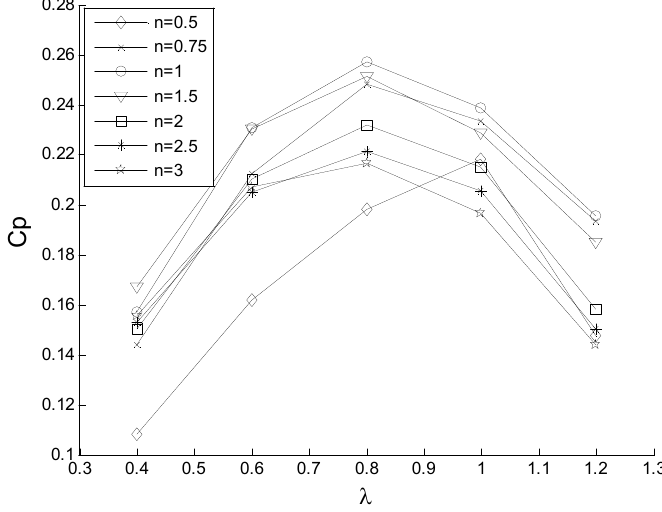
Figure 8. Coefficient of power with respect to λ for turbines with different blade